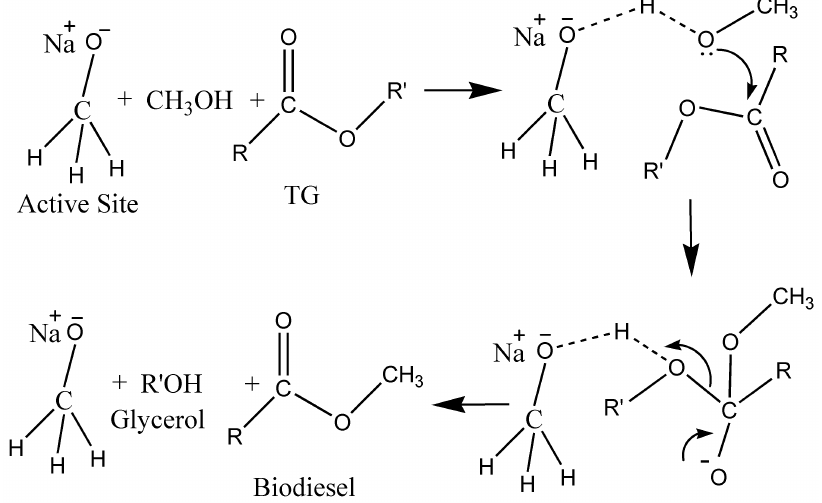
Figure 13. Plausible heterogeneous catalytic mechanisms: ( a ) Active site formation; ( b ) Transesterifi- cation of WCO using NaOMe/zeolite.